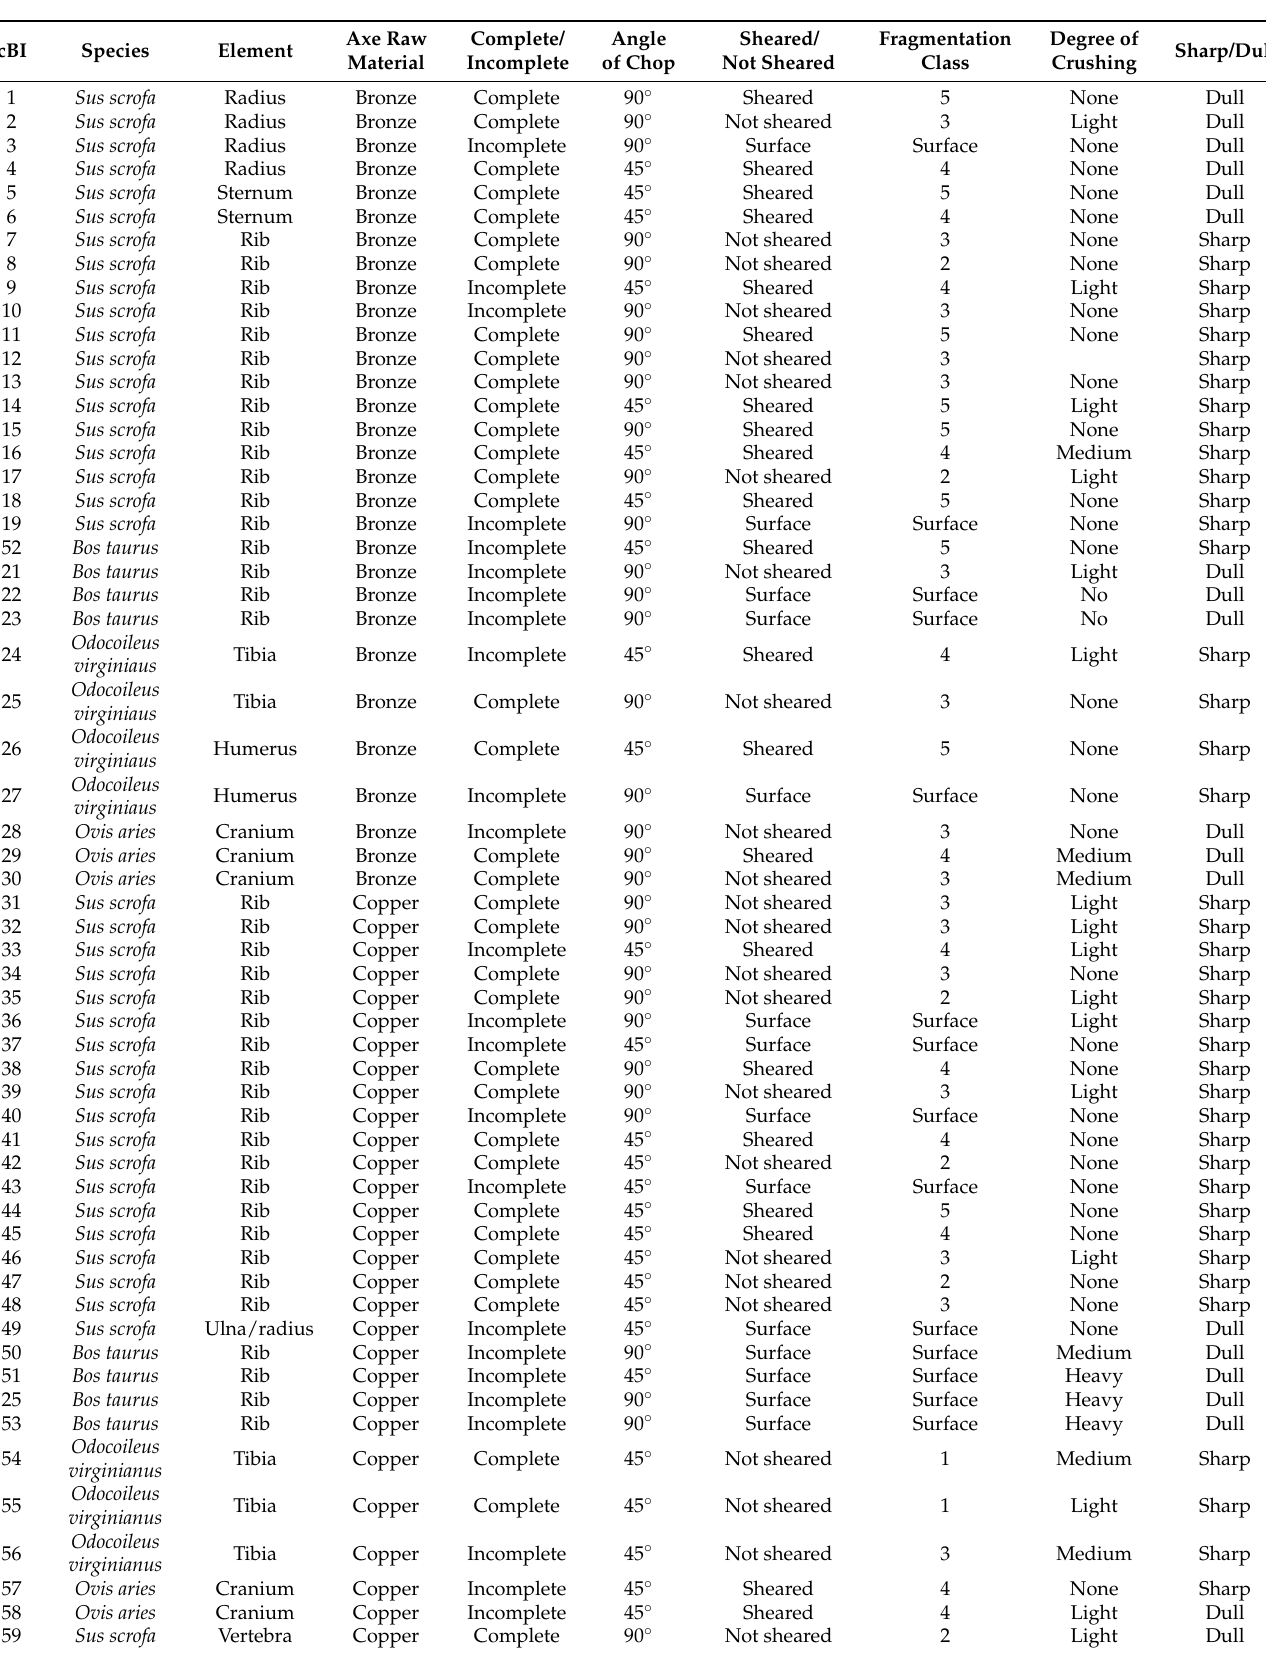
Table 3. Summary of data for all experimental axe chop marks (cBI— chopped Butchering Incident